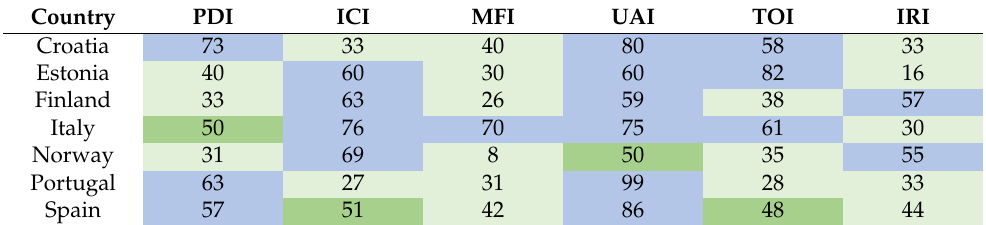
Table 1. Scores of predictor variables (Hofstede’s cross ‐ cultural dimensions) for the seven countries included in the study [25].